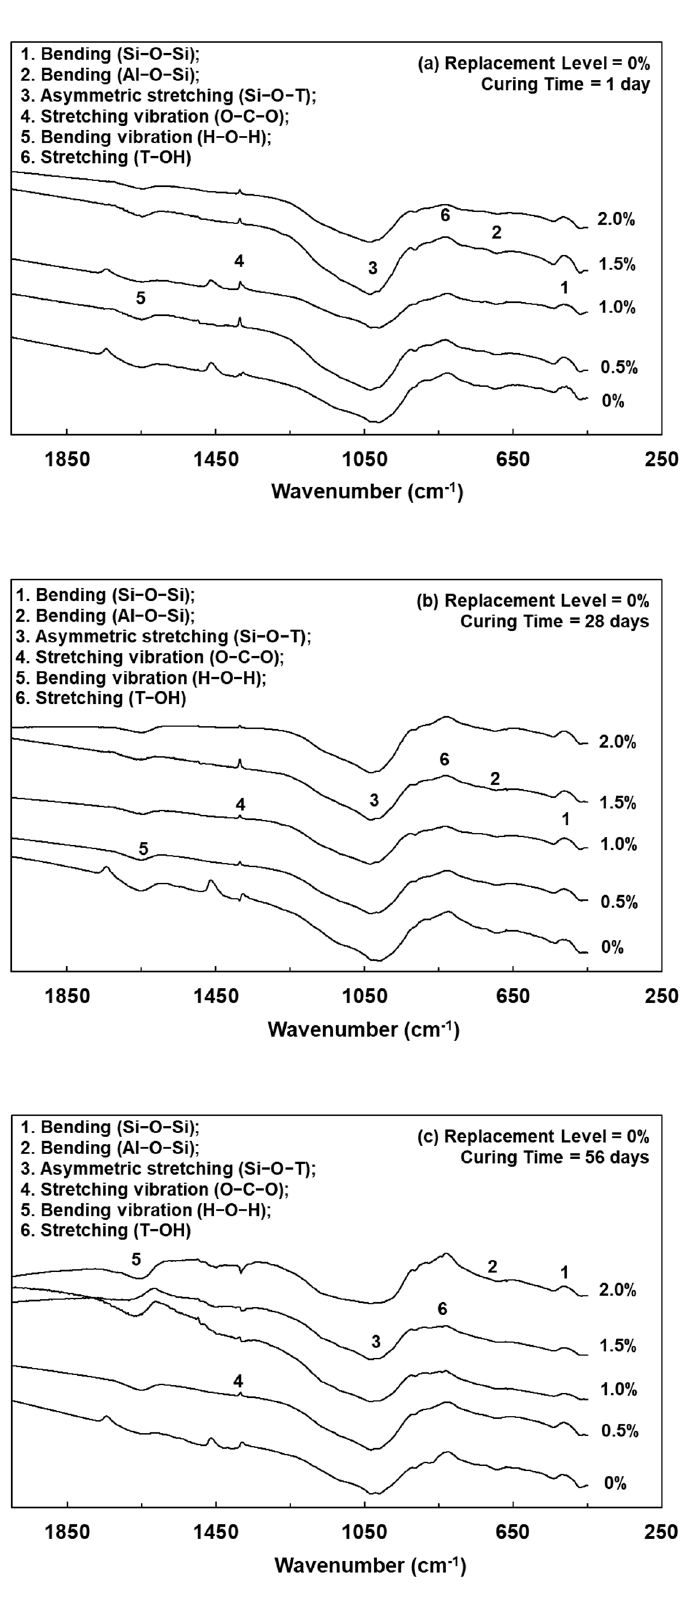
Figure 3. FTIR spectrums of lightweight FGPs. (Replacement level = 0%). ( a ) 1day; ( b ) 28 days and ( c ) 56 days